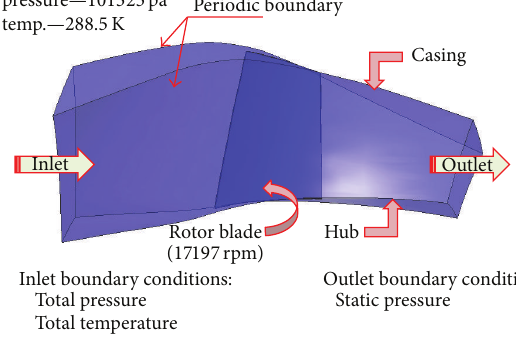
Figure 3: Boundary conditions.